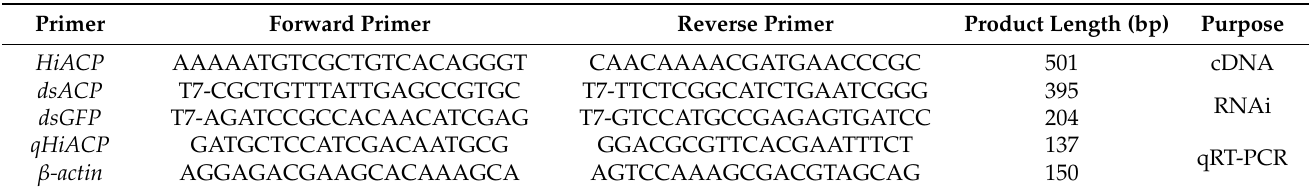
Table 1. Sequences of primers for DNA cloning, dsRNA synthesis, and qRT-PCR.